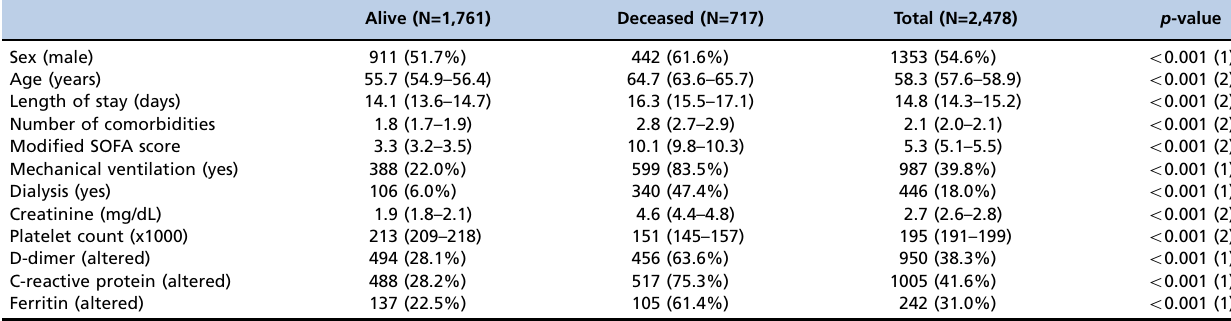
Table 1 - Patients ’ characteristics by primary